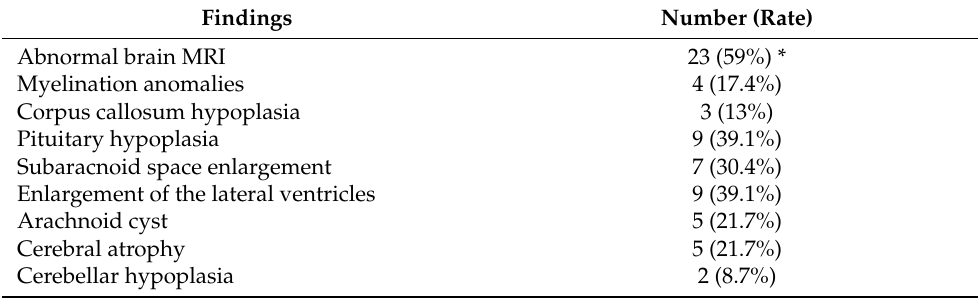
Table 3. Brain magnetic resonance imaging (MRI) findings in the patients with Prader–Willi syndrome ( n =